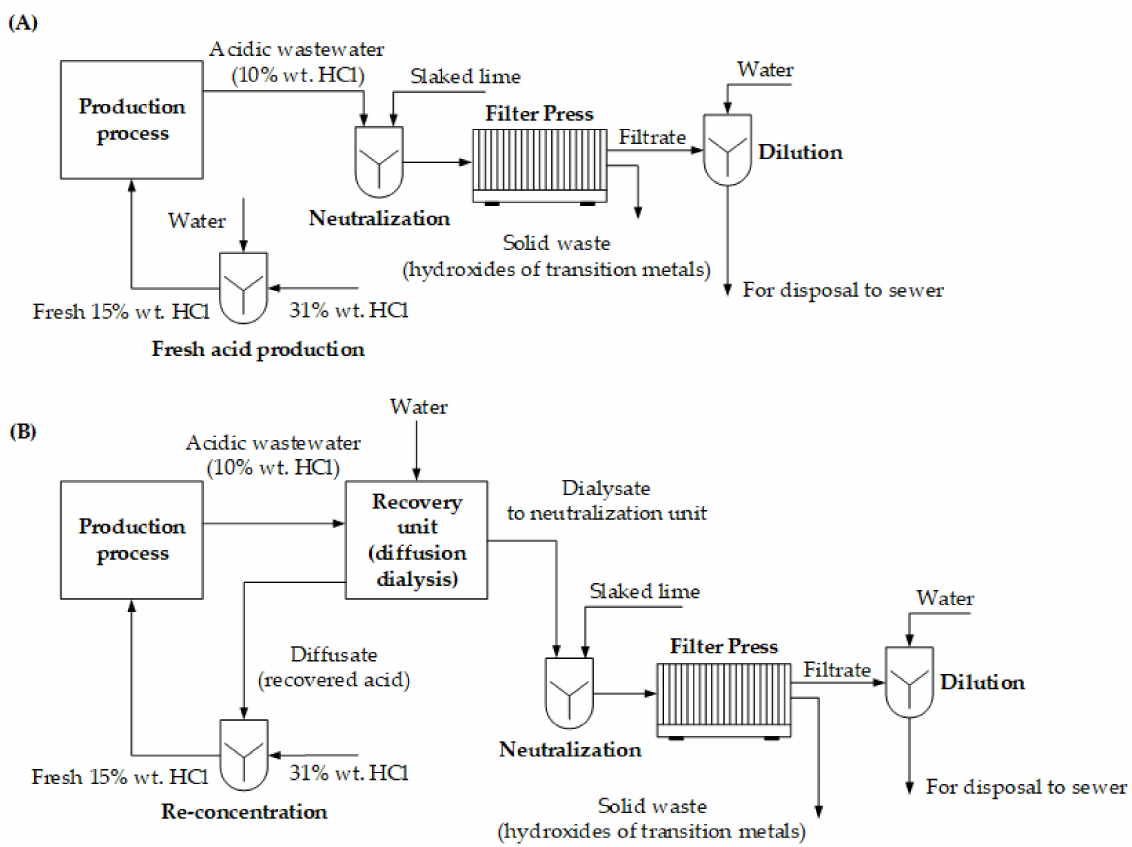
Figure 6. Proposed technology for HCl-rich wastewater treatment. ( A ) Treatment of acidic wastew- ater without diffusion dialysis; ( B ) implementation of diffusion dialysis into production-level wastewater management.